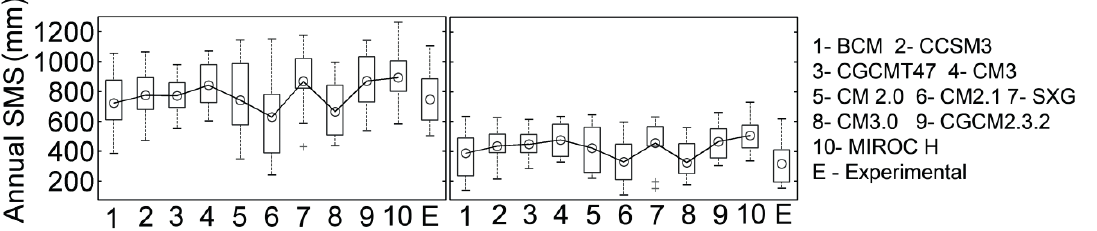
Fig. 2 Annual SMS for pasture (left) and sugar-cane (right). GCMs ASMS mean (circles) are connected by the line. Outliers are shown as small crosses.